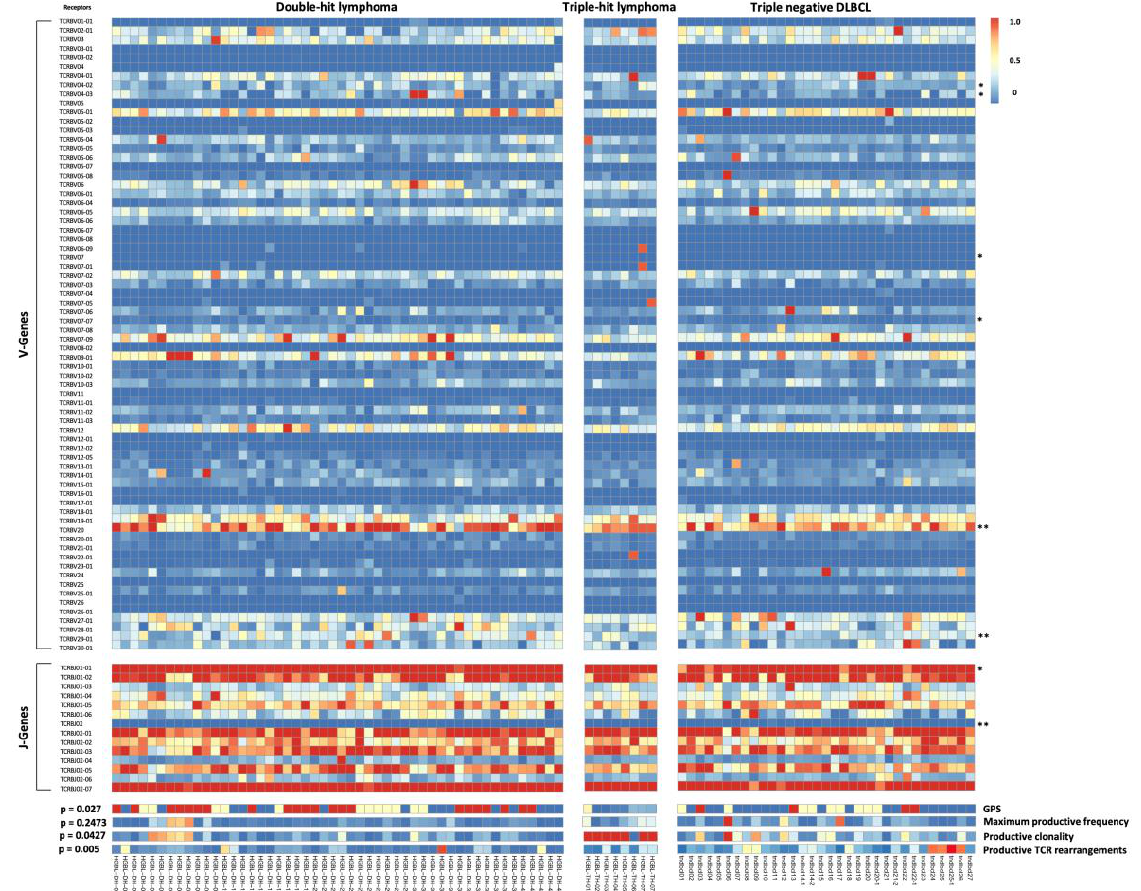
Figure 3. The usage of Vβ- and Jβ-genes in tumor samples from HGBL DH/TH samples as well as biopsy specimen acquired at relapse compared with tnDLBCL Heatmap of the usage frequency. For several Vβ- and Jβ-segments a significant differential usage between pooled HGBL-DH/TH-samples at diagnosis and tnDLBCL samples was observed and was subsequently marked with * p < 0.07 (results bordering on statistical significance) and ** p < 0.05 (significance level) according to two-tailed t-test.